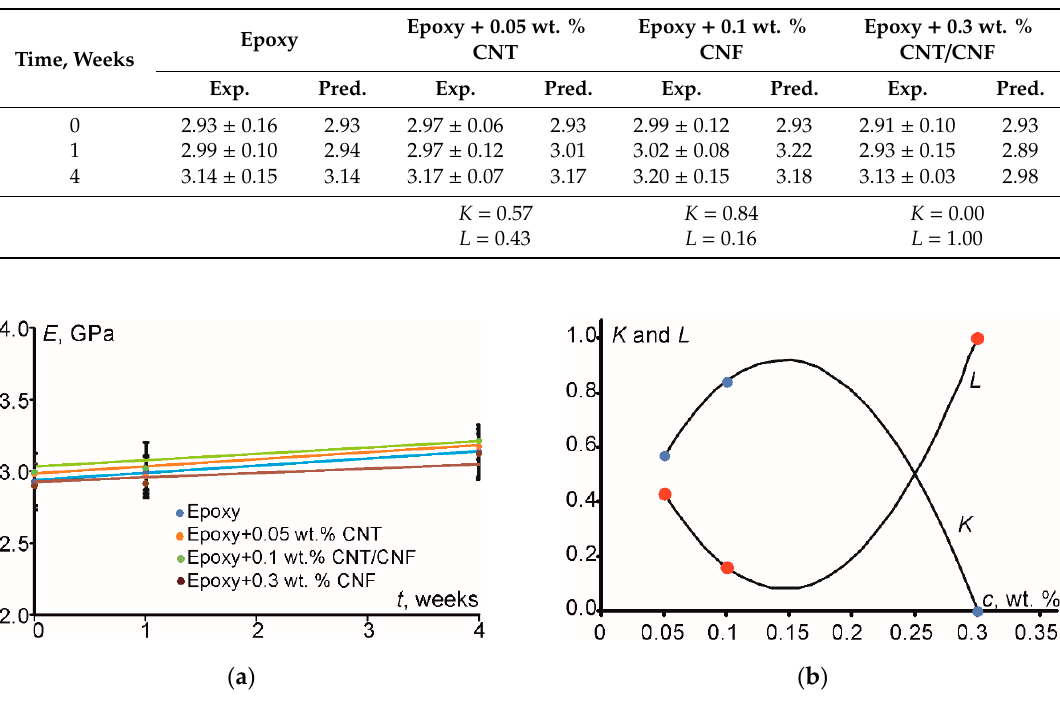
Table 3. Experimental and predicted elastic modulus for the specimens stored in water at 70 ◦ C.